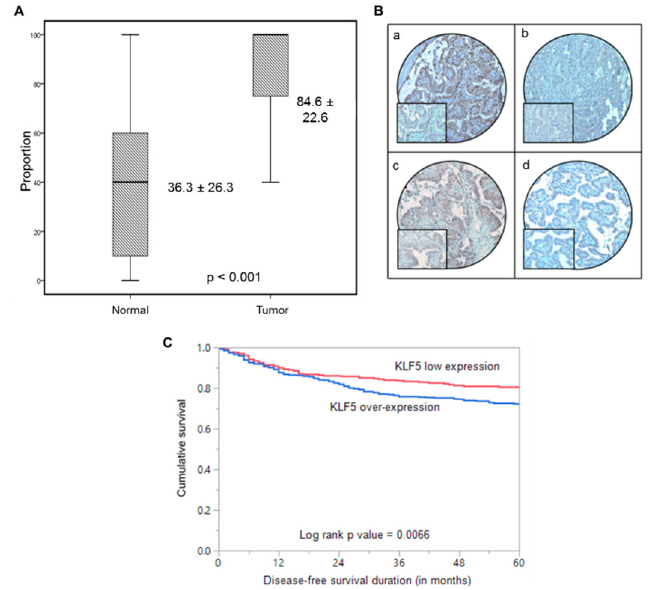
Figure 1. Immunohistochemical analysis of KLF5 and HIF-1 α expression in Papillary Thyroid Cancer (PTC) TMA. ( A ) KLF5 expression in normal thyroid and papillary thyroid carcinoma (PTC) tissues. A significant difference in expression levels was noted between normal thyroid ( n = 225) and PTC tissues ( n = 1219) ( p < 0.001). ( B ) PTC array spot showing overexpression of KLF5 ( a ) and HIF-1 α ( c ). In contrast, another PTC tissue array spot showing low expression of KLF5 ( b ) and HIF-1 α ( d ). 20X/0.70 objective on an Olympus BX 51 microscope. (Olympus America Inc, Center Valley, PA, USA) with the inset showing a 40X 0.85 aperture magnified view of the same TMA spot. ( C ) Kaplan–Meier survival analysis for the prognostic significance of KLF5 expression in PTC. PTC patients with overexpression of KLF5 had reduced disease-free survival at 5 years on univariate analysis compared to tumors showing low expression of KLF5 ( p = 0.0066). Table 1. Clinico-pathological associations of KLF5 protein expression in PTC.